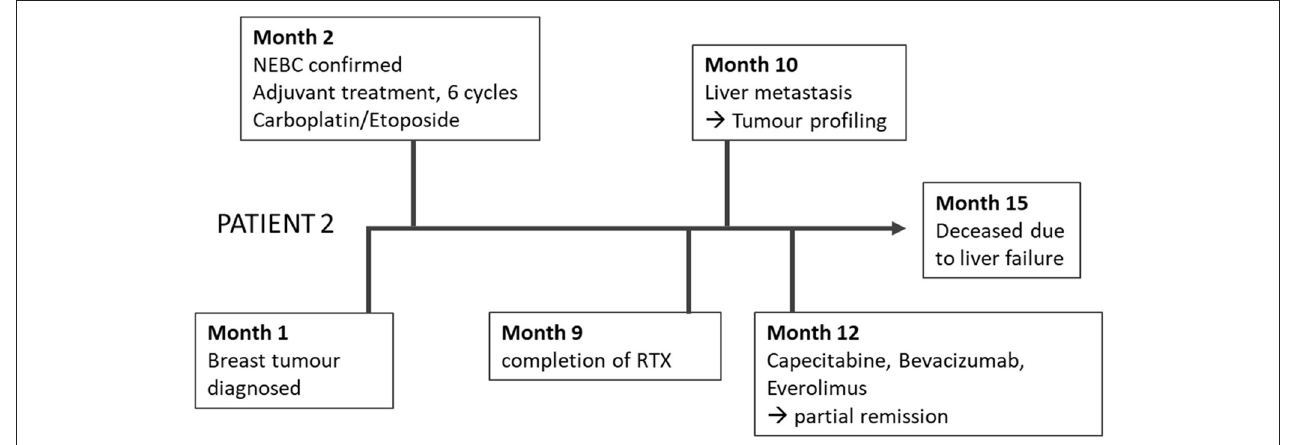
FIGURE 2 | Timeline of Patient